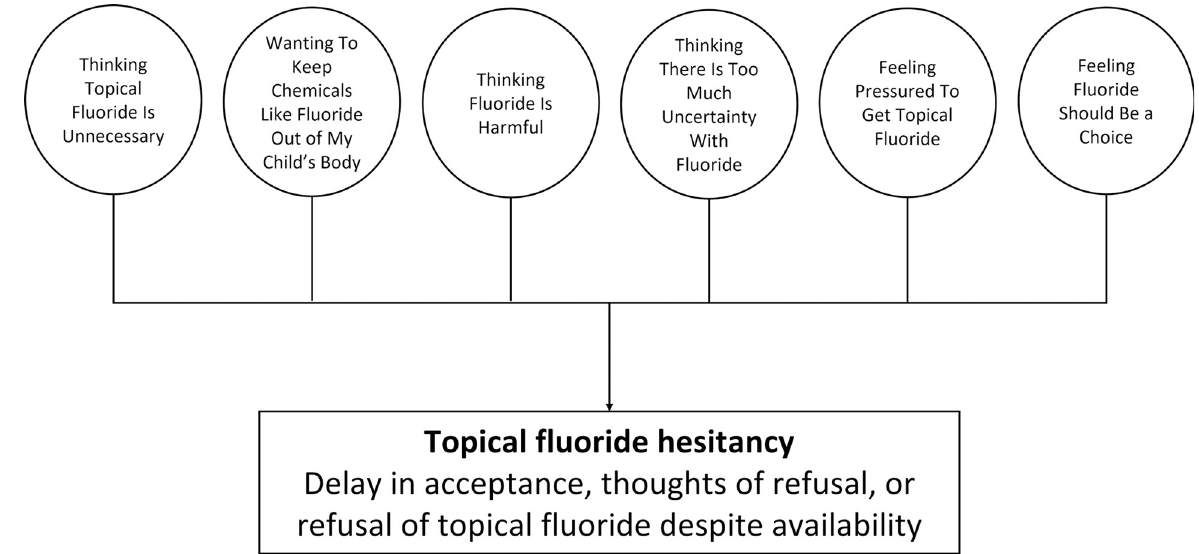
Fig 1. Conceptual model on caregivers’ hesitancy of topical fluoride for their children with six domains.